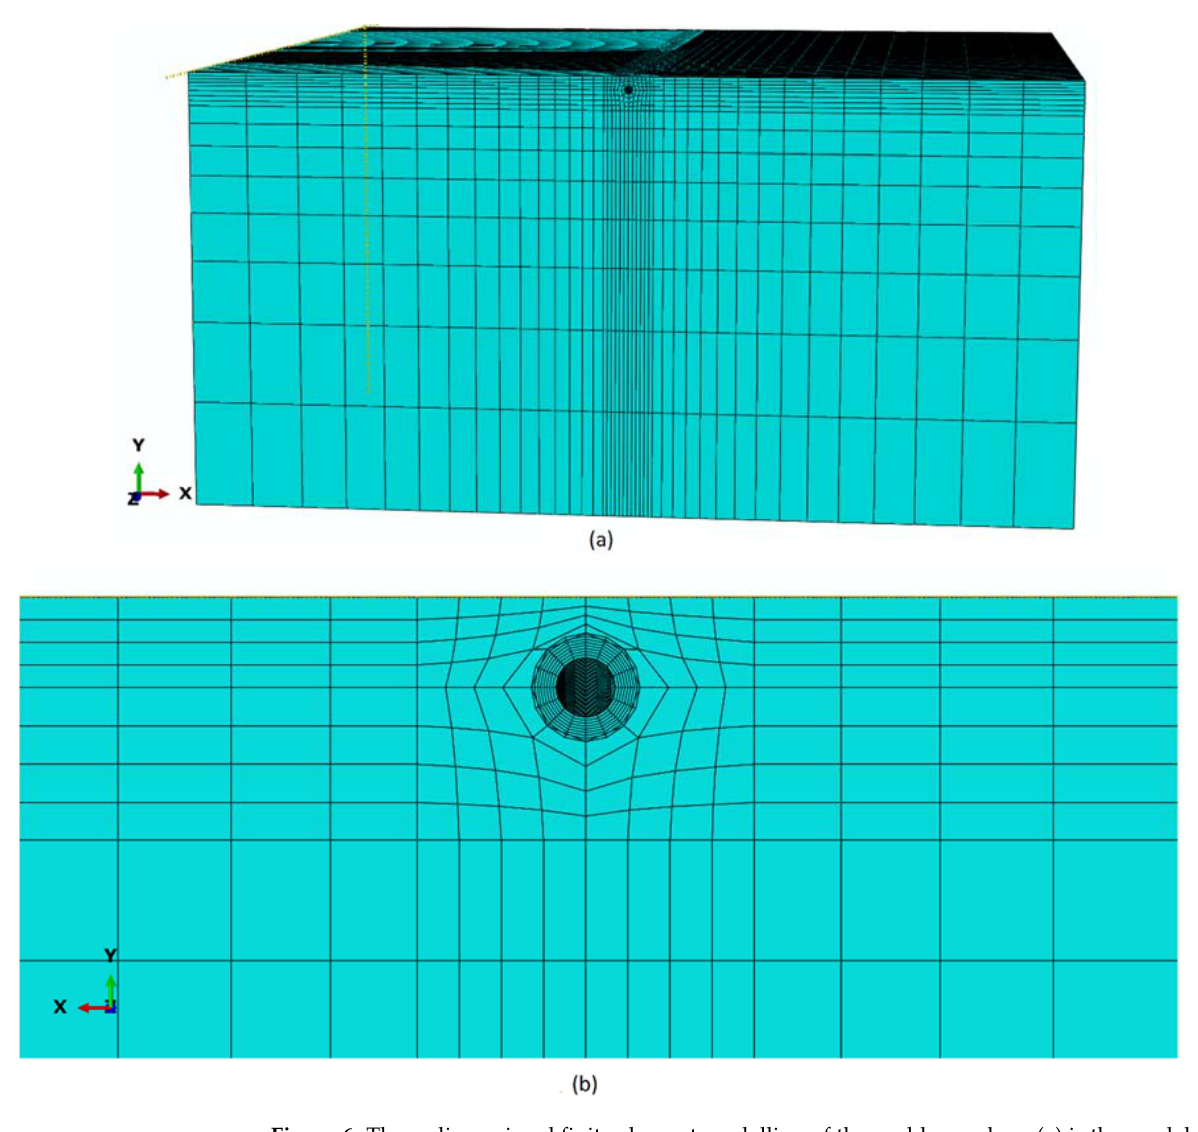
Figure 6. Three-dimensional finite element modelling of the problem, where ( a ) is the model of the problem and ( b ) the detailed mesh around the pipe and meta-material layout’s area. XYZ refers to the rectangular coordinate system.